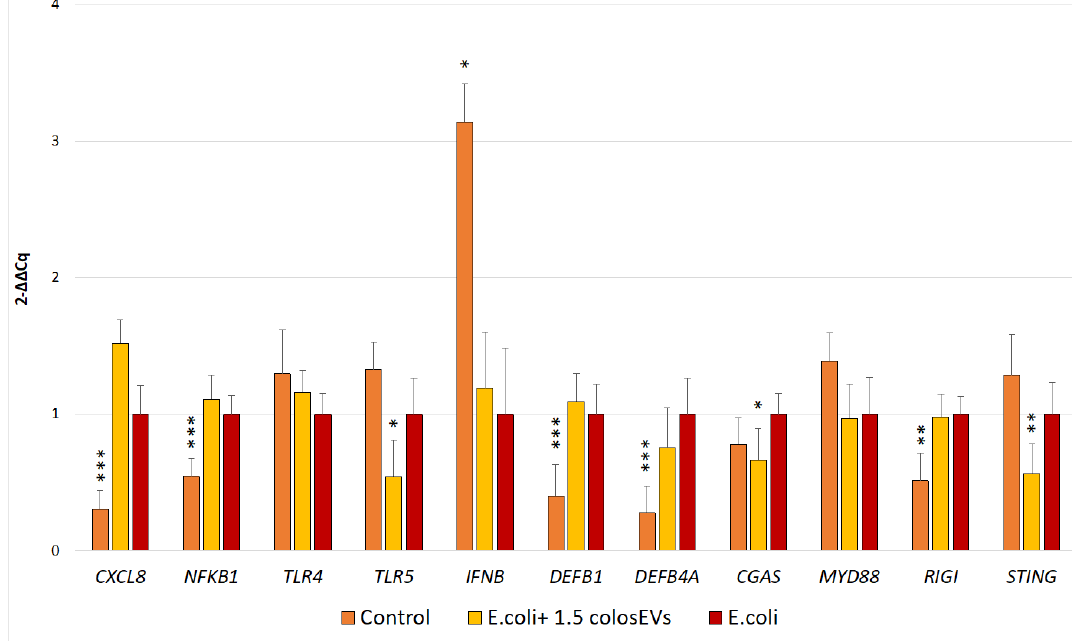
Figure 3. Effect of 48 h +1.5 μg colosEVs on E. Coli -inflamed IPEC-J2 cells. IPEC-J2-tested conditions were: inflamed ( E. coli , pink), inflamed 1.5 μg colosEVs ( E. coli + 1.5 μg colosEVs, light yellow), untreated (control, dark yellow). Significant differences are reported with respect to infected cells with E. coli . Differences were evaluated through the Kruskal–Wallis test and applying the post hoc Dunn’s multiple comparison test. The asterisks indicate the statistical significance: * p < 0.05, ** p < 0.01 and *** p < 0.001.